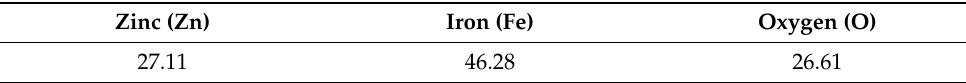
Figure 1. XRD patterns of prepared zinc ferrite. Table 1. The chemical composition of zinc ferrite sample (wt.%).